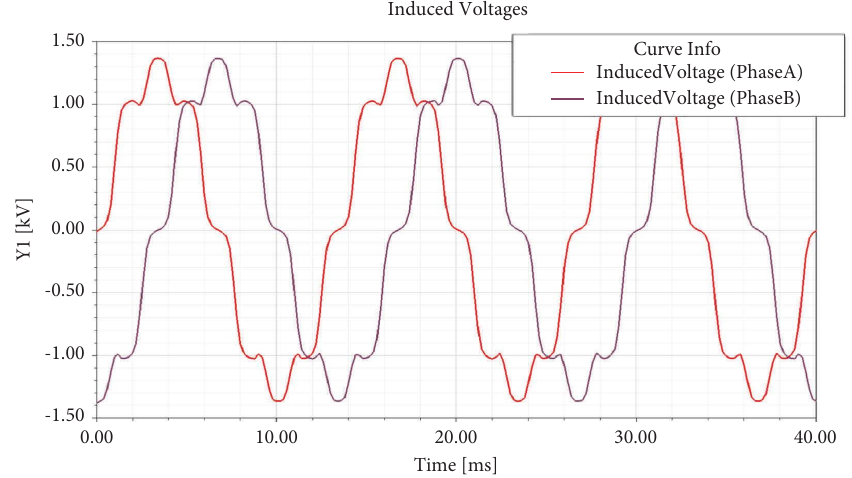
Figure 21: Back EMF curve of 6-pole 24-slot motor.